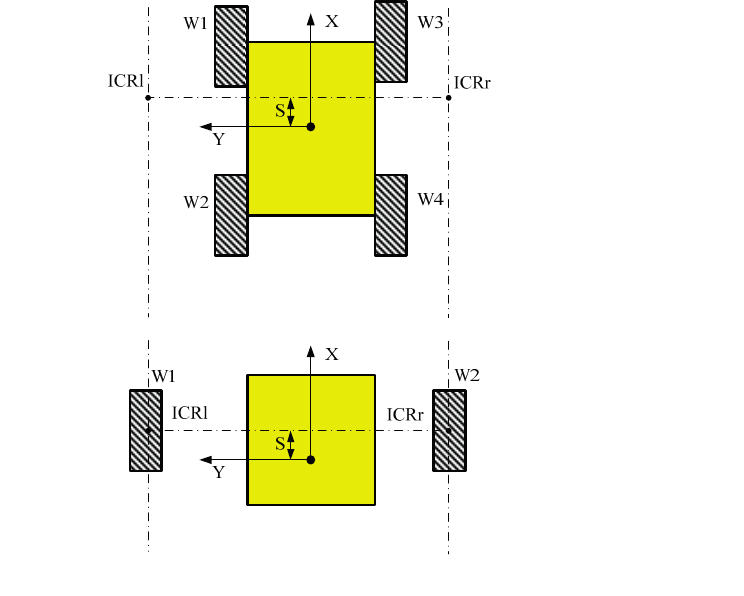
Figure 2. Geometric equivalence between the wheeled skid-steering robot and the ideal differential drive